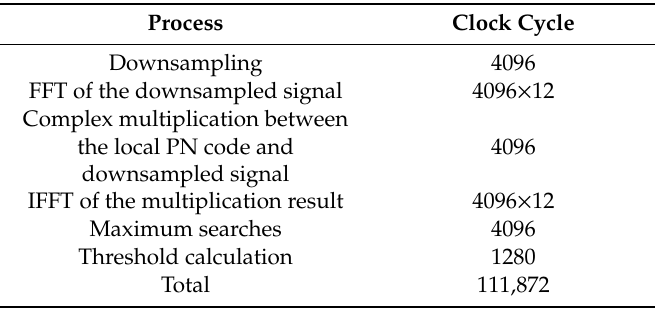
Table 2. Required clock cycles for once acquisition process.